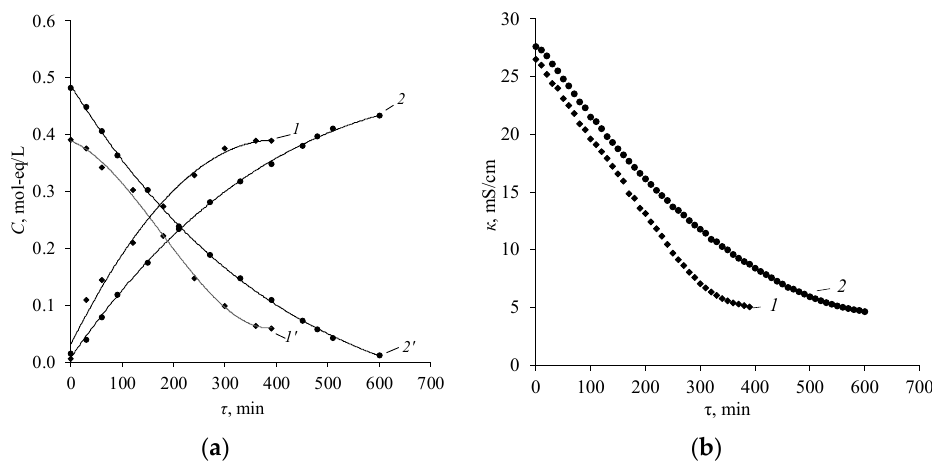
Figure 16. Dependence of the concentrations diethylamine ( 1 , 2 ) and diethylammonium sulfate